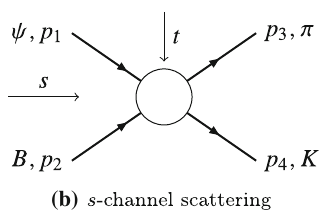
Fig. 1 Reaction diagrams for a the B → ψ( → μ − μ + )π K decay process, and for b the ψ B → π K s -channel scattering process. The t -channel process ψπ → ¯ BK is indicated by the vertical